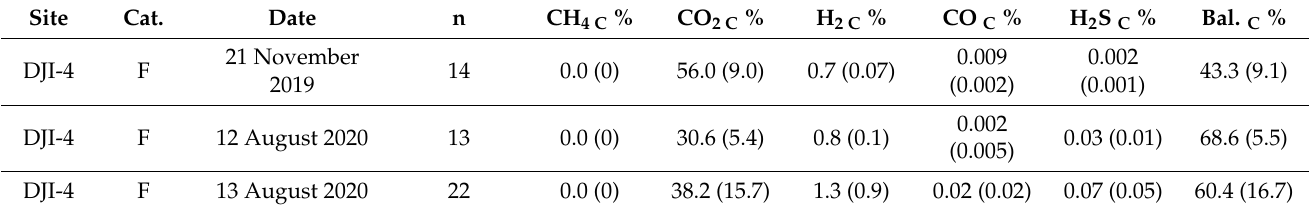
Table 5. Gas chromatography data from site 4, including non-corrected and air-corrected measurements. Site